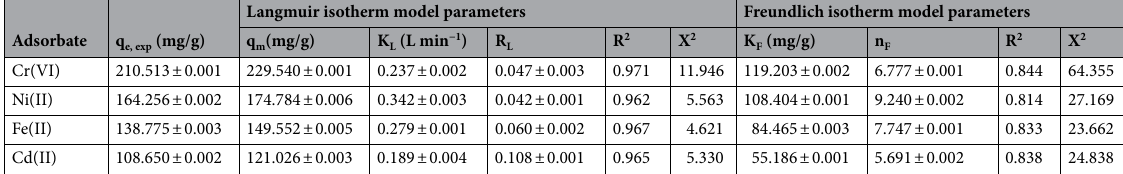
Table 3. Calculated isotherm model parameters for metal ions adsorption by